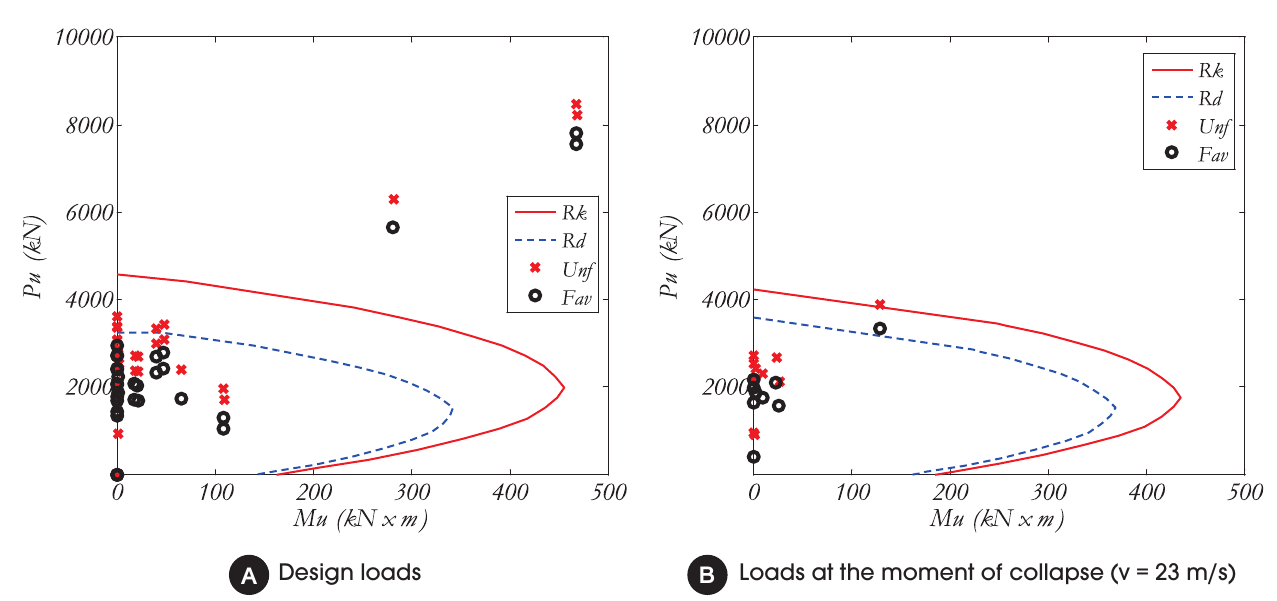
Interaction diagram of column P08